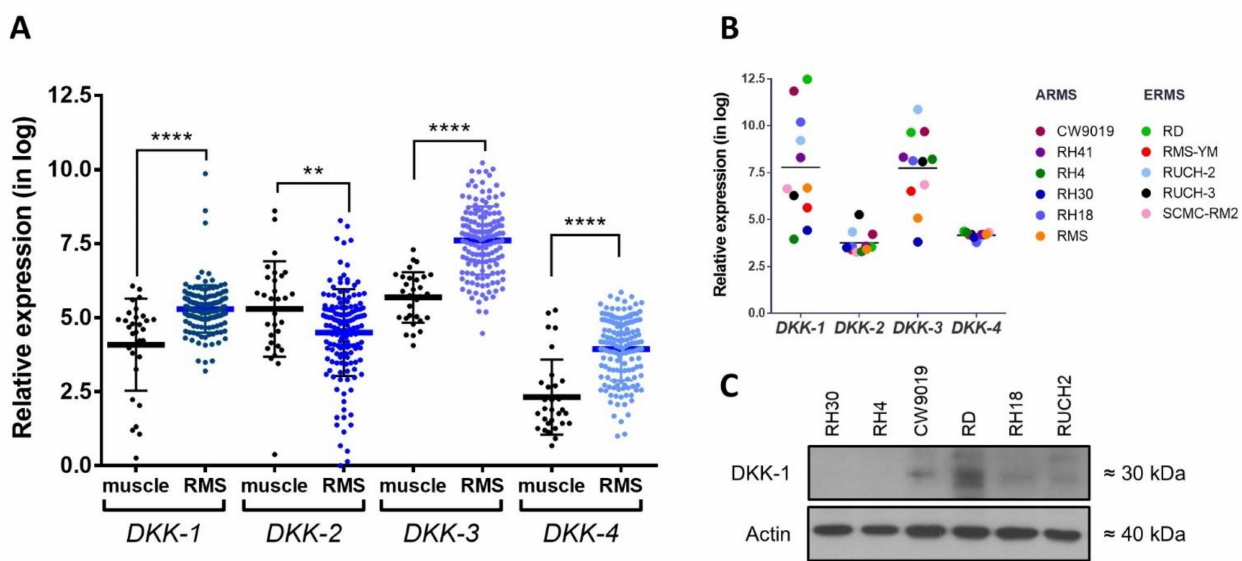
Figure 1. Expression analysis of DKK family members in RMS. ( A ) Relative mRNA expression of DKK genes in RMS patients, extracted from expression datasets, compared with muscle as the matched healthy counterpart. ( B ) Analysis of expression dataset revealed remarkable DKK-1 and DKK-3 overexpression in RMS cell lines. ( C ) Representative Western